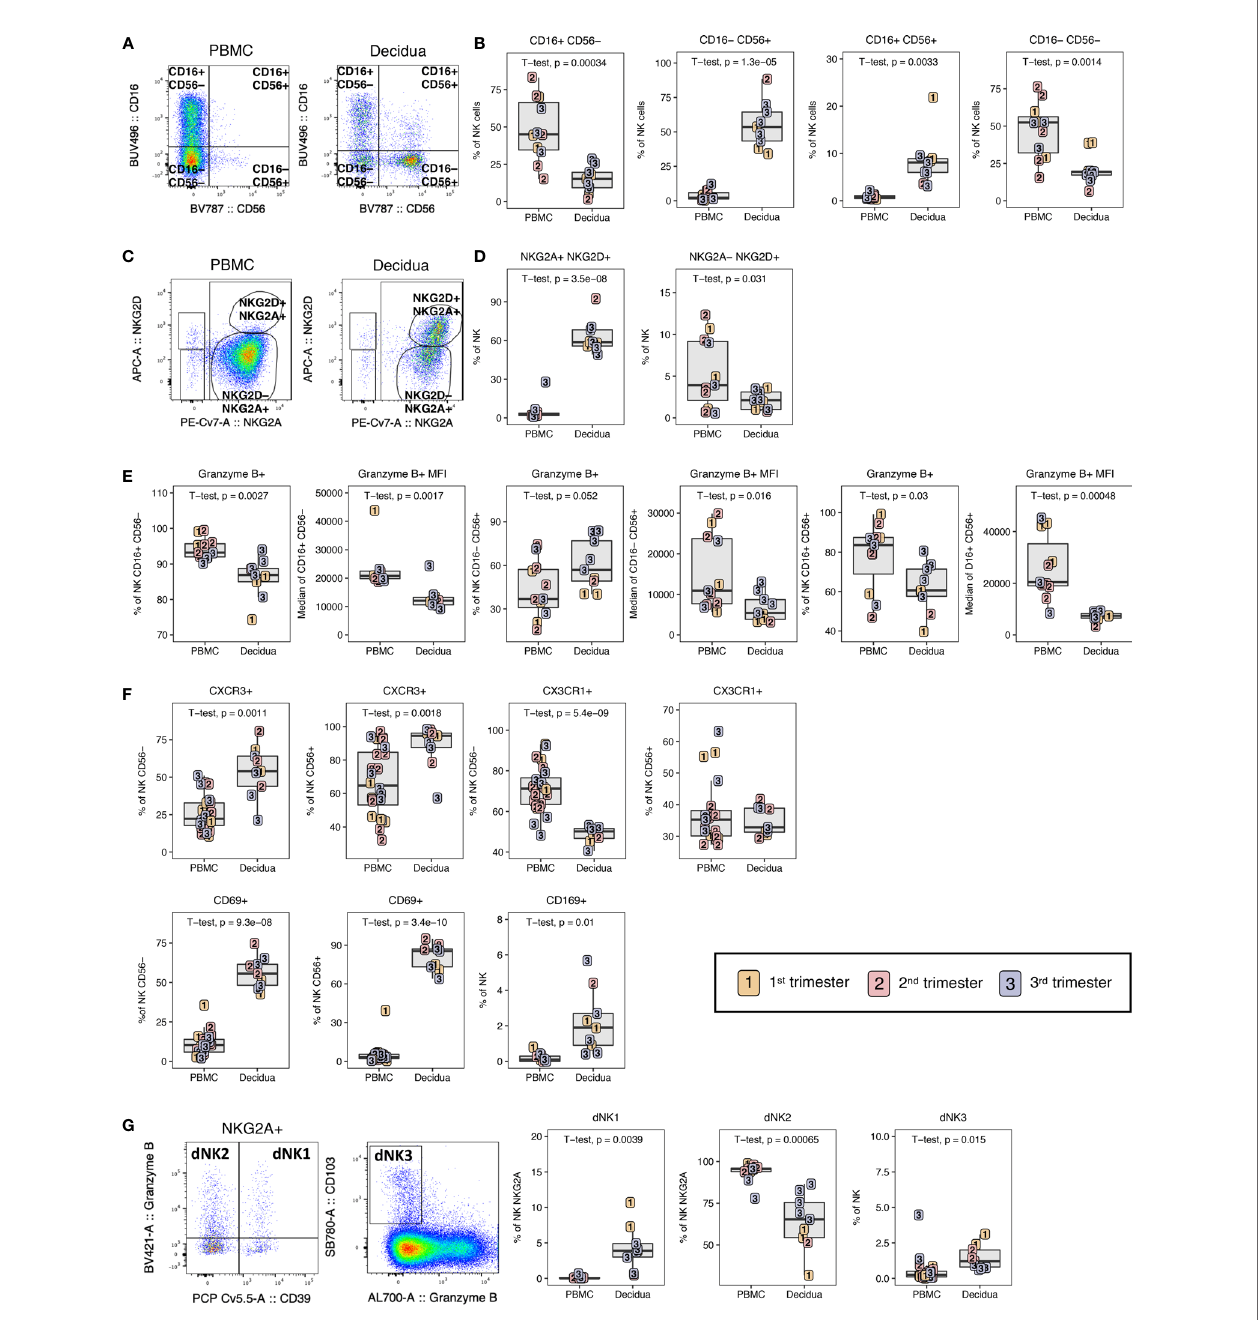
FIGURE 8 | NK cell composition in PBMC and decidua of normal rhesus macaque pregnancies. (A) Representative fl ow plots of NK cells CD16/CD56 subsets. (B) NK cell subset frequencies in PBMC and decidua fi rst (yellow), second (red) and third trimester (blue) of normal pregnant rhesus macaques. (C) NKG2A/NKG2D fl ow plots with representative gating of PBMC and decidua. (D) Frequency of NKG2A+NKG2D+ and NKG2A-NKG2D+ NK cells in PBMC and decidua. (E) Granzyme B expression frequency and MFI on NK cell subsets. (F) CD56- vs CD56+ NK cell expression of CXCR3, CX3CR1, CD69 and the CD169 on total NK cells. (G) Representative fl ow plot of dNK1, dNK2, and dNK3 subsets with box plots showing their frequency in PBMC and decidua. P-values < 0.05 (unpaired t-test) shown on the